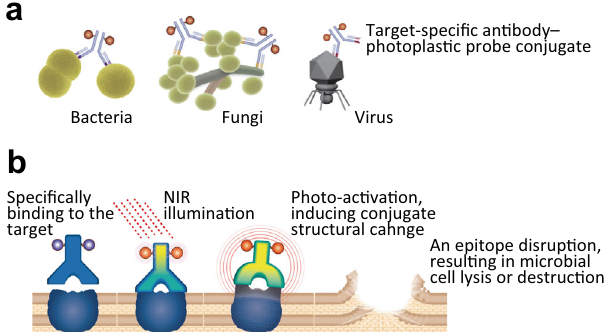
Fig. 1 Target microbes and the proposed mechanism of PIAS. a Anti- target pathogen antibody – photoplastic probe IR700 conjugates bind to the target pathogens. b Scheme indicates the proposed microbicidal mechanism of PIAS based on our